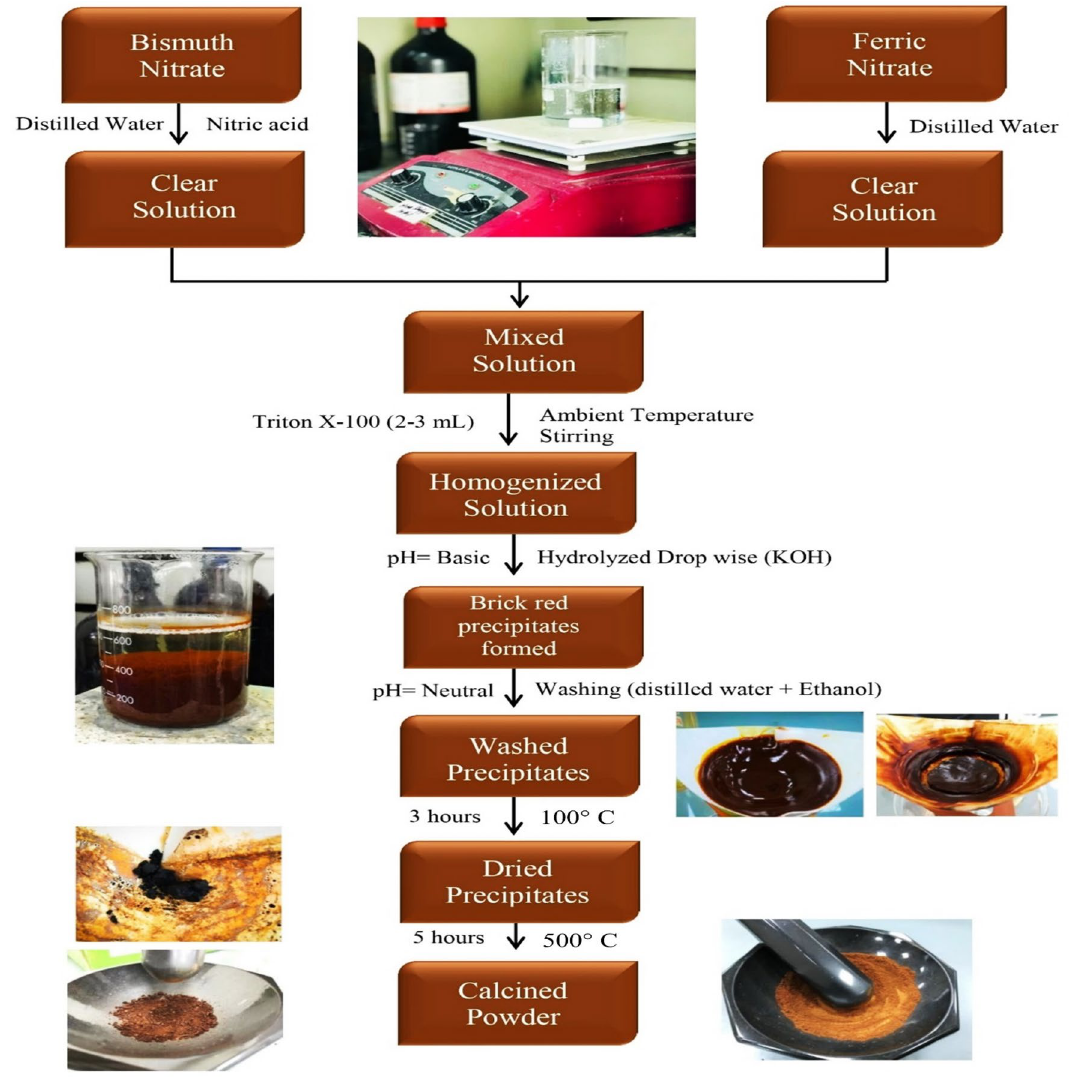
Figure 1. Synthesis process of BiFeO 3